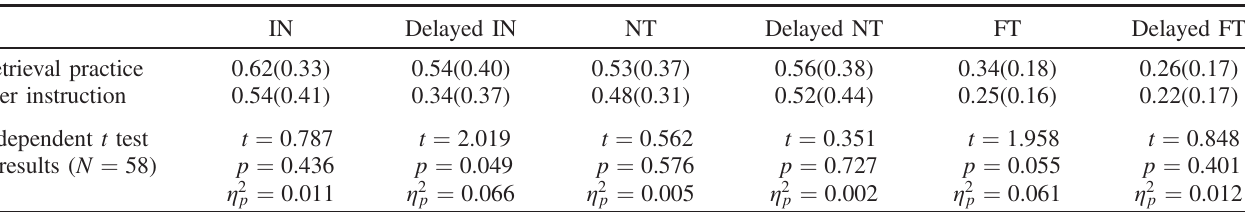
TABLE I. Mean and S.D. values and independent samples t -test results for the initial (IN), near transfer (NT), and far transfer (FT) tasks on both immediate and delayed final tests for both conditions. IN